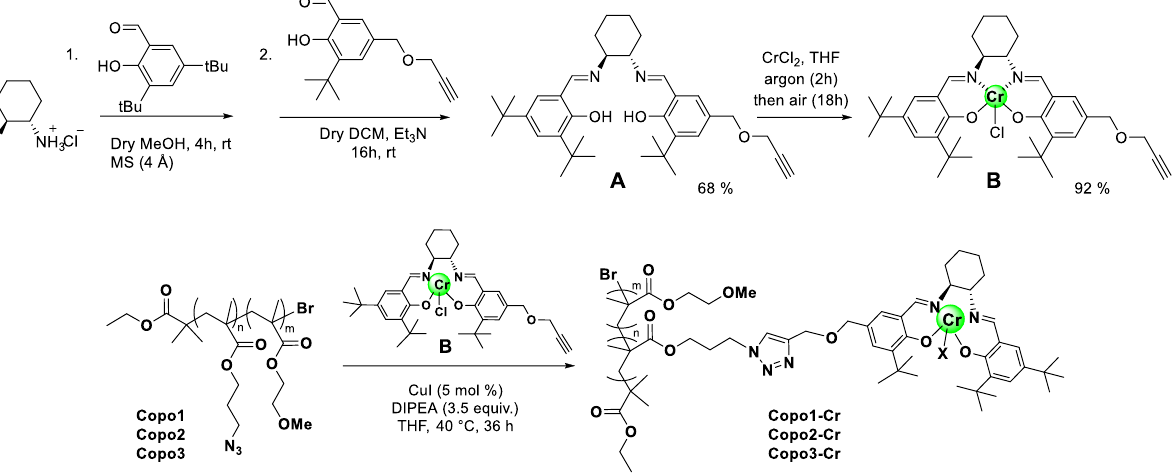
Figure 6. ATR-IR spectra of copolymers .